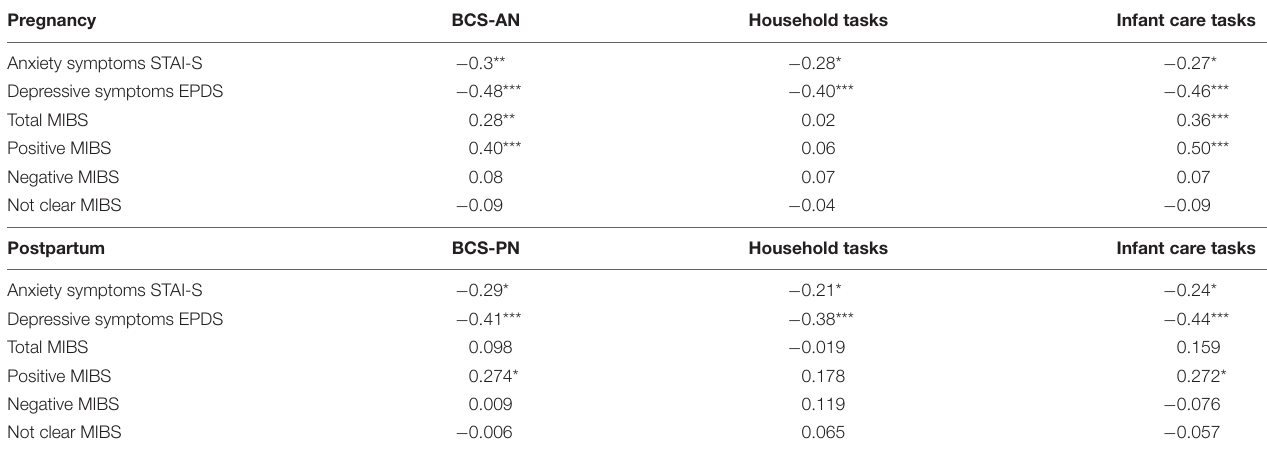
TABLE 5 | BCS-AN and BCS-PN criterion validity: correlations with anxiety and depressive symptoms, and father–infant emotional involvement during pregnancy and the postpartum period, respectively. Pregnancy BCS-AN Household tasks Infant care tasks